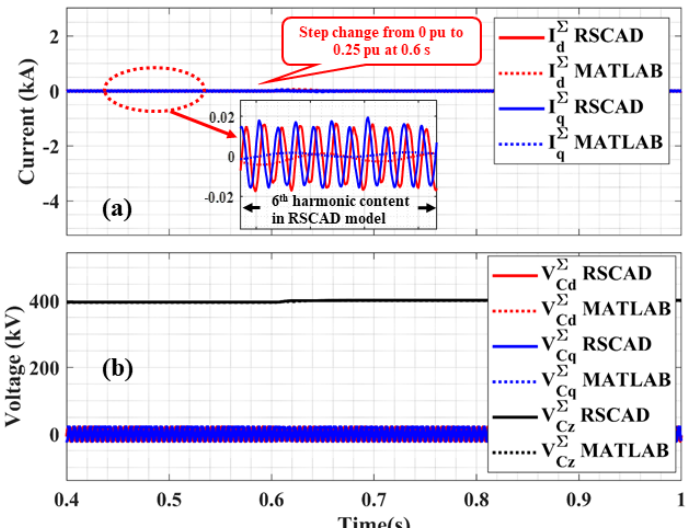
Figure 8. Comparison of: ( a ) active power; ( b ) reactive power; ( c ) i ∆ MATLAB (blue) and RSCAD (red) during step change in reactive power from 0 p.u. to 0.25 p.u. at the time instance t = 0.6 s.